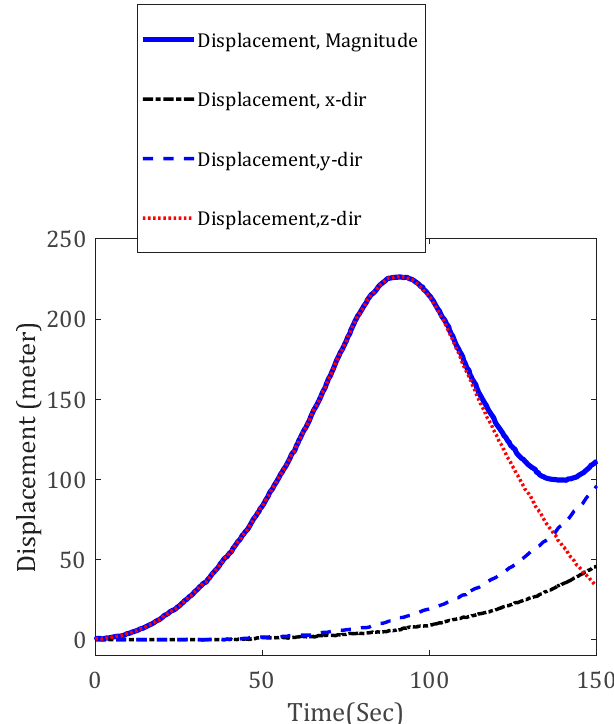
Figure 8. Variation of displacements in the compatibility scenario.